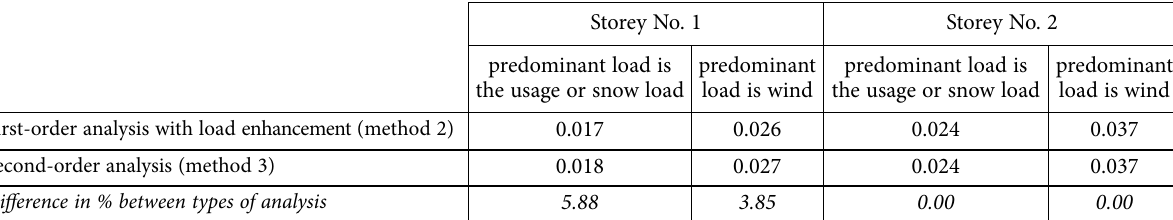
Table 4. Results of frame deformations calculated by methods 2 and 3 Storey No. 1